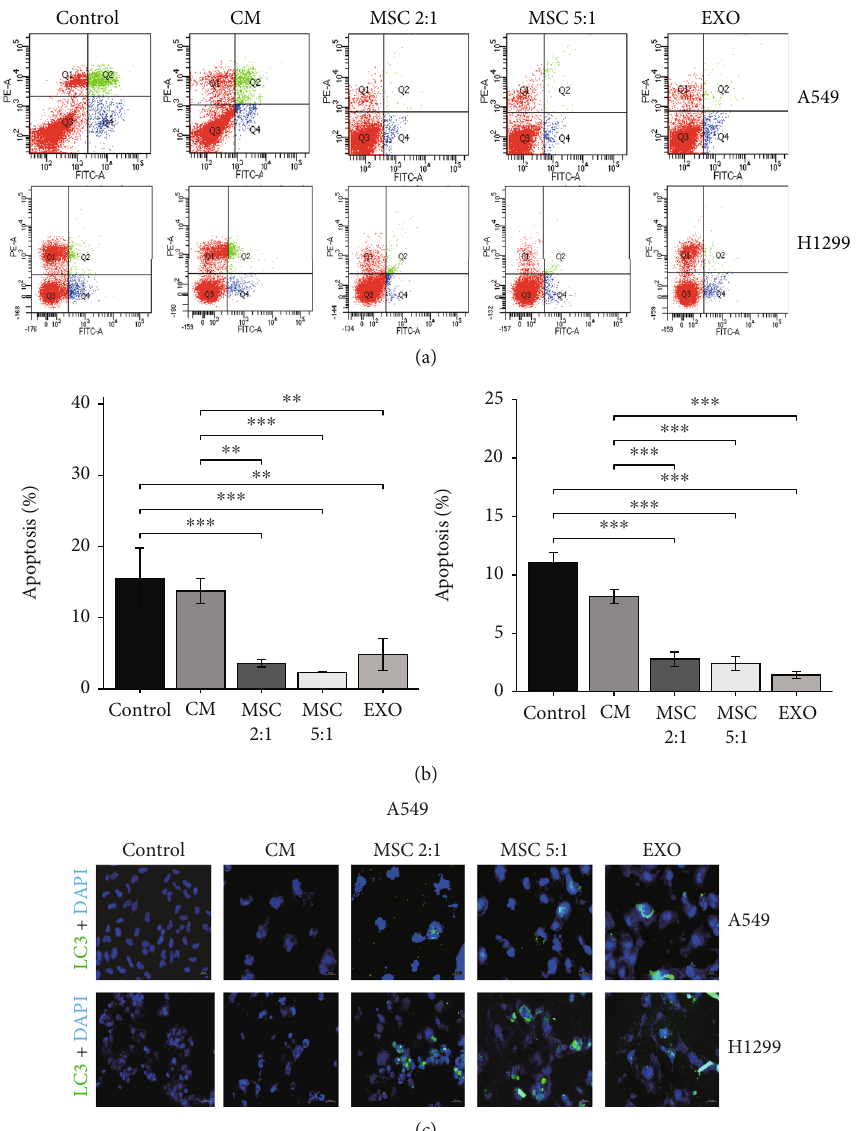
Figure 5: MSCs and MSC-exosomes reduced apoptosis and promoted autophagy in the polyploid A549 and H1299 cells. (a, b) Apoptosis analysis of the polyploid A549 and H1299 cells following coculture with MSC-CM, MSCs, and MSC-exosomes was examined by fl ow cytometry at 48 hours. (c) Stained with anti-LC3A/B antibody to detect the LC3 puncta and DAPI to detect nuclei by immuno fl uorescence using a fl uorescence microscope ( ×